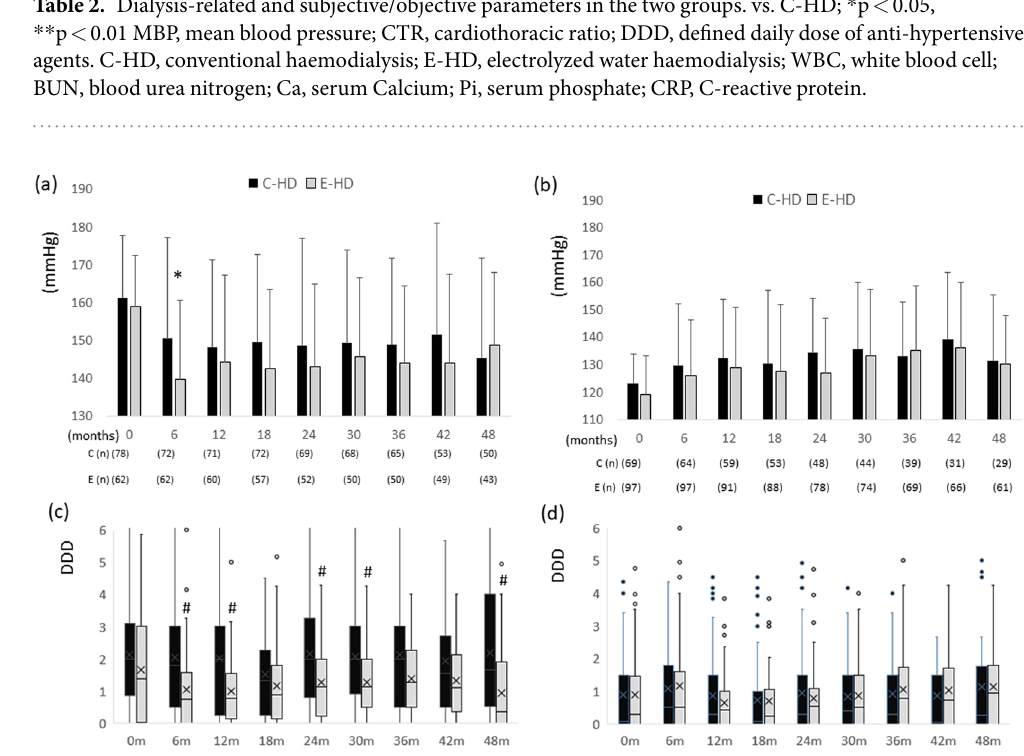
Table 2. Dialysis-related and subjective/objective parameters in the two groups. vs. C-HD; * p < 0.05,